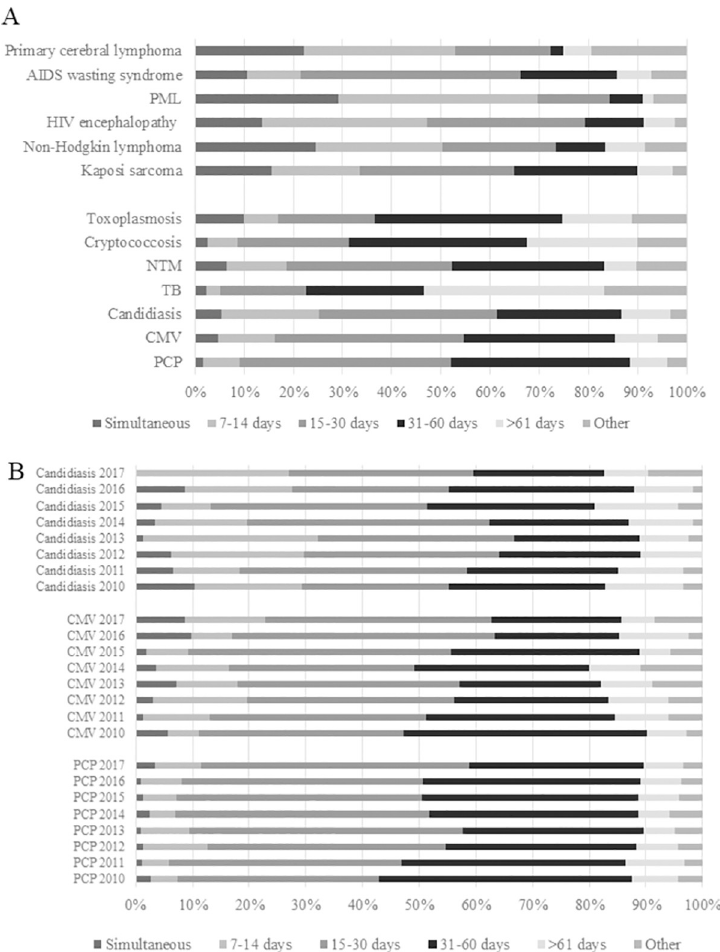
Fig 4. Time trends of antiretroviral therapy (ART) initiation. (A) Time to ART initiation after diagnosis of acquired immunodeficiency syndrome-defining illnesses (ADIs): cumulative data from 2010 to 2017. Regarding infectious diseases, ART was mostly introduced 15–30 days after malignancies and non-infectious encephalopathy were detected. Particularly for tuberculosis (TB), more than half of the patients initiated ART > 2 months after HIV diagnosis. ART was mostly initiated earlier for central nervous system (CNS)-related diseases such as progressive multifocal leukoencephalopathy (PML) and primary cerebral lymphoma with approximately 60% and 80%–90% human immunodeficiency virus (HIV) patients initiated ART within 14 and 30 days after diagnosis, respectively. (B) Time to ART initiation after the diagnosis of ADIs (three major infectious diseases): an 8-year comparison (2010–2017). Most HIV patients received ART > 15 or > 31 days after